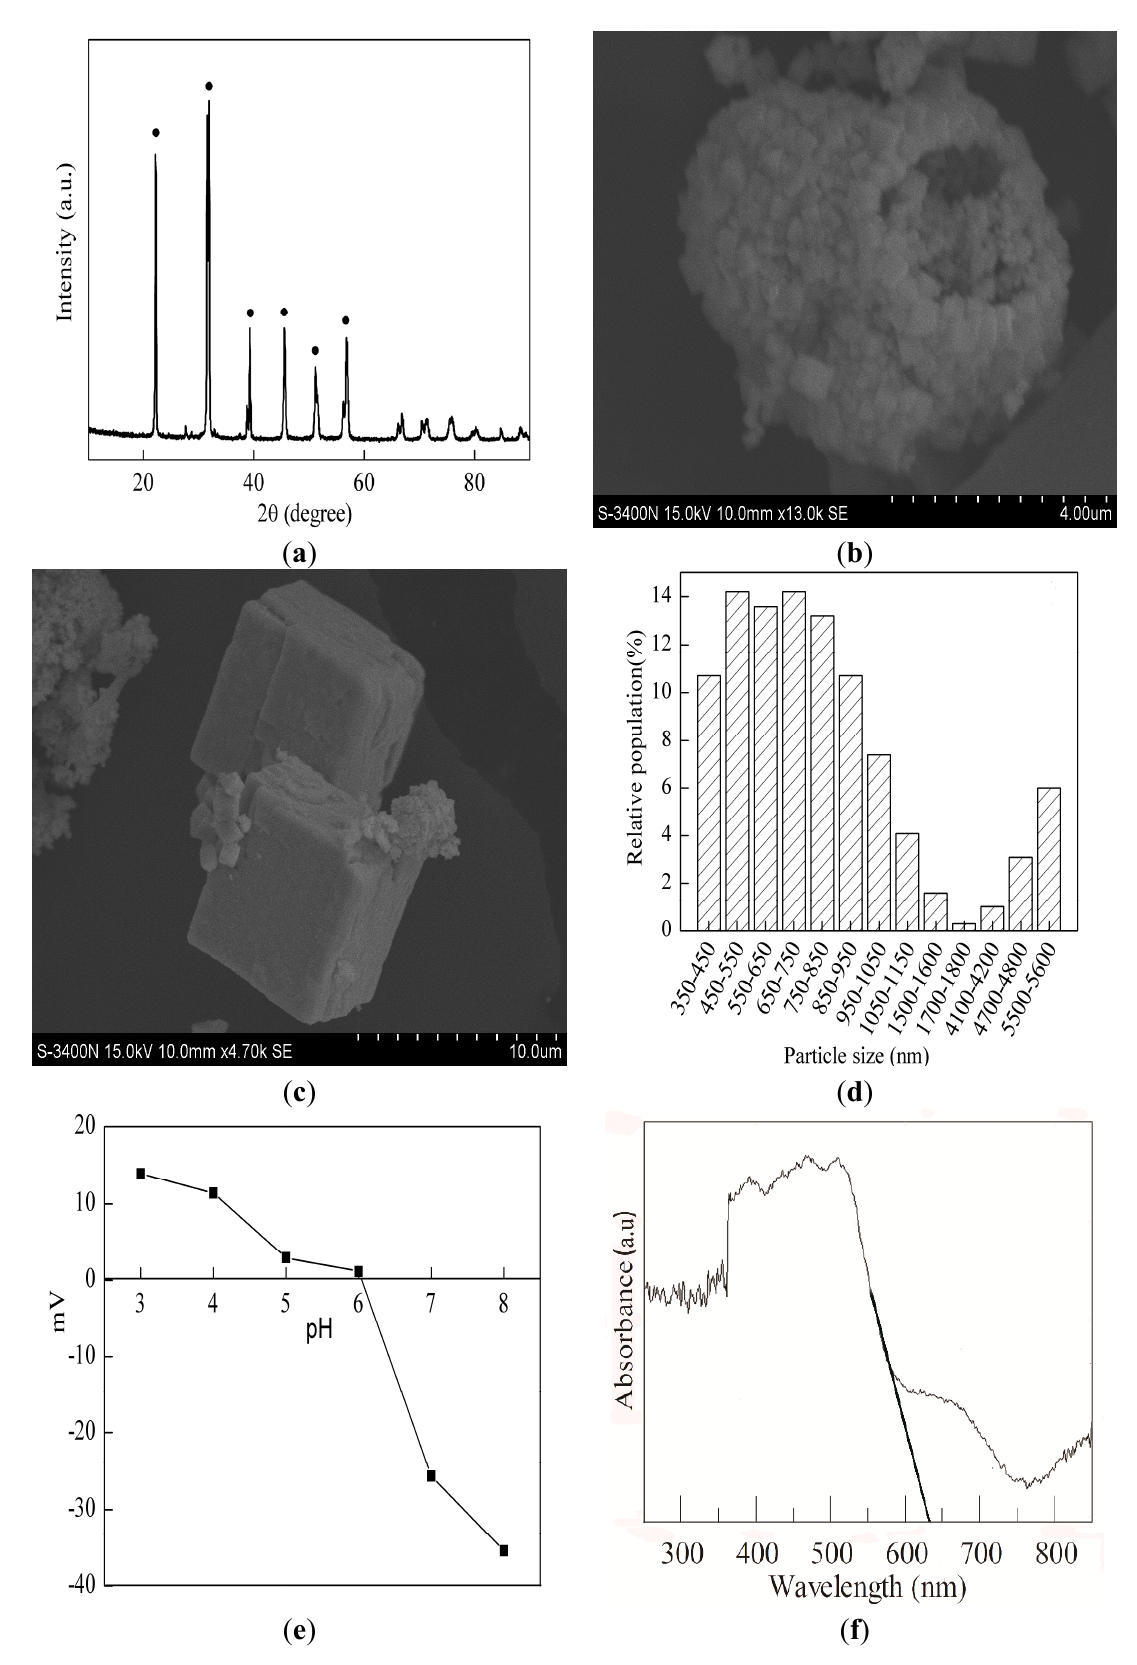
Figure 1. ( a ) XRD pattern of BiFeO 3 (BFO); ( b , c ) SEM images of BFO; ( d ) Particle size distribution of BFO; ( e ) Zeta potential of BFO at different pH values; ( f ) UV-VIS spectra of BFO.